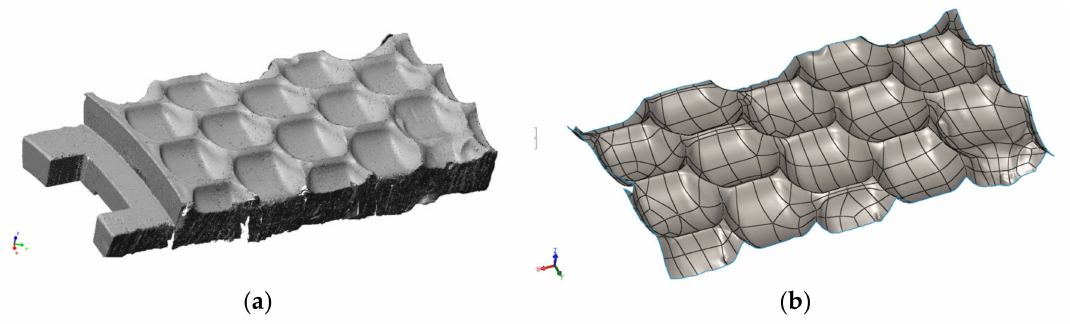
Figure 6. Matrix three-dimensional (3D) model. ( a ) Result of the matrix optical scanning in a form of a cloud of points, done by means of the ROMER measuring arm; ( b ) Obtained in the SolidWorks